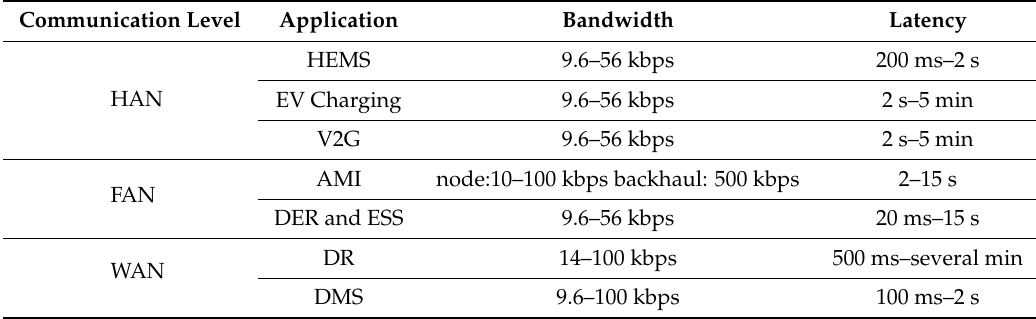
Table 2. Communication specification application in